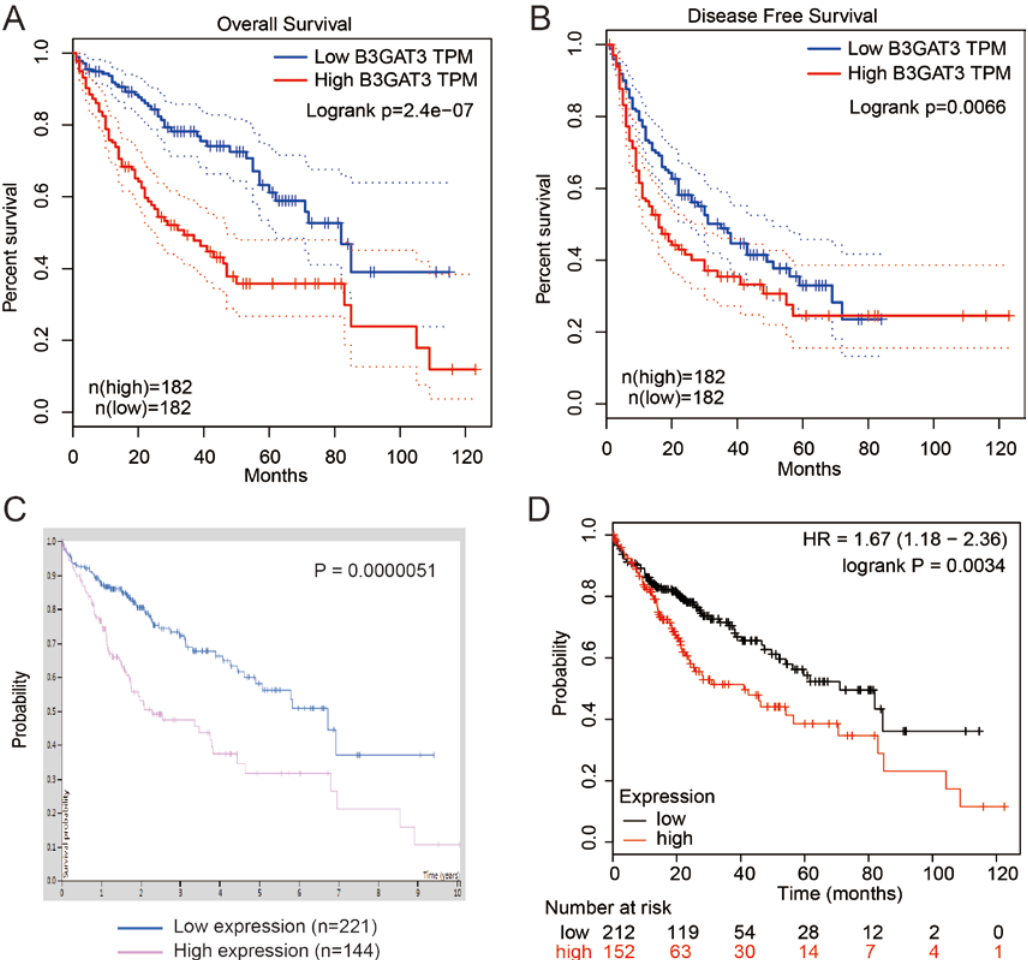
Figure 2: High B3GAT3 expression was unfavorable for the prognosis in human liver cancer. GEPIA was used for the analysis of OS (A) and DFS (B) of patients with differences in B3GAT3 expression level. (C) The human protein atlas was used to analyze the prognostic role of B3GAT3. (D) B3GAT3 prognostic value was also investigated in KM plotter, and the desired Affy- metrix IDs was 26229. All the above results showed that high B3GAT3 level was associated with poor